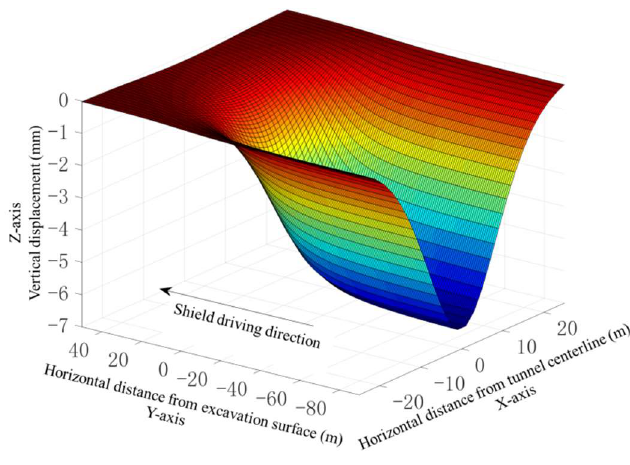
Figure 9. Ground movements induced by ground loss.